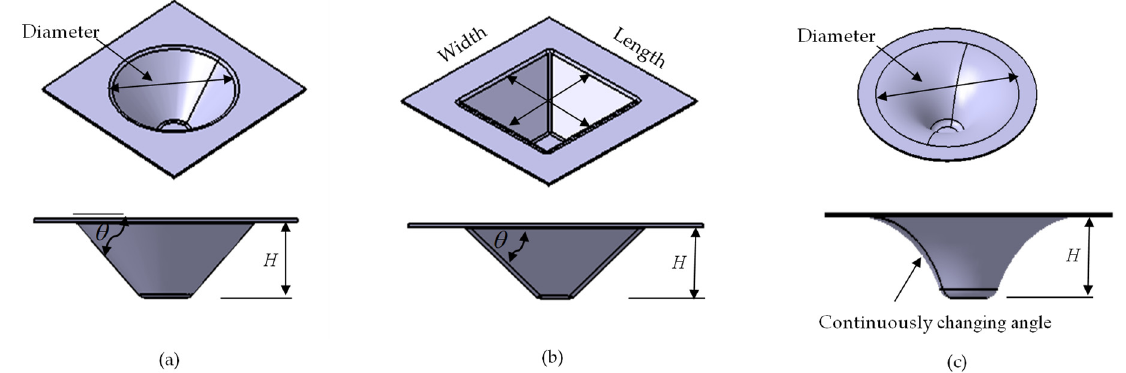
Figure 11. ISF benchmark shape ( a ) cone ( b ) pyramid ( c )